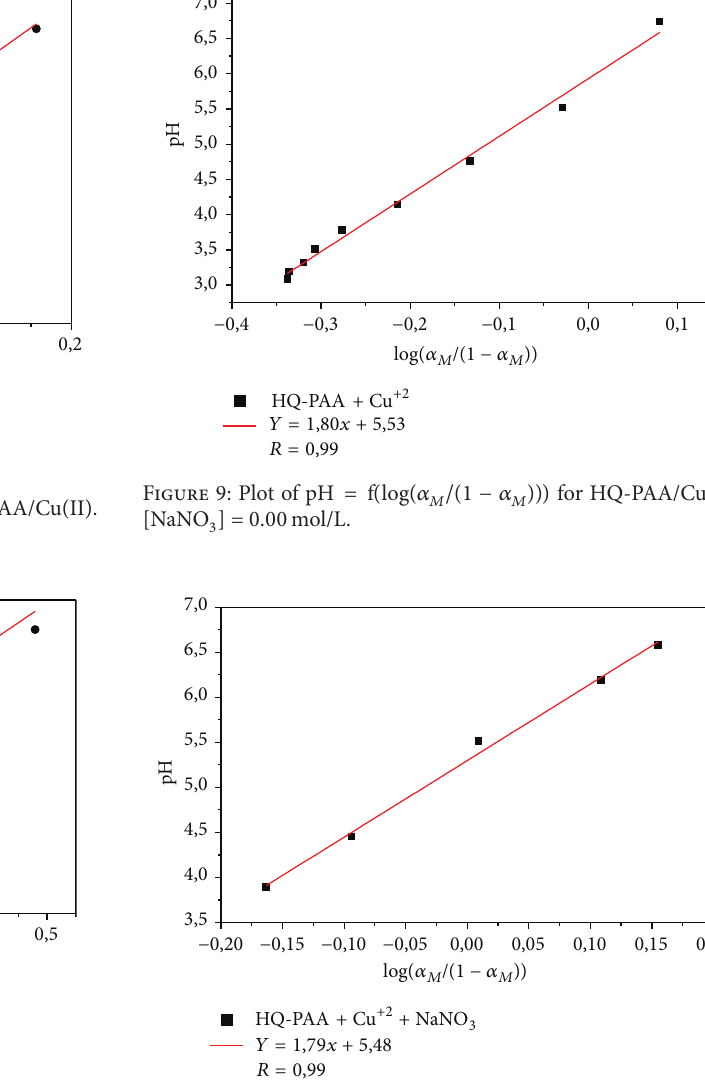
Figure 8: Plot of pH = f ( log (𝛼 𝑀 /(1 − 𝛼 𝑀 ))) for PAA/Cu(II). [NaNO 3 ] = 0.01mol/L.